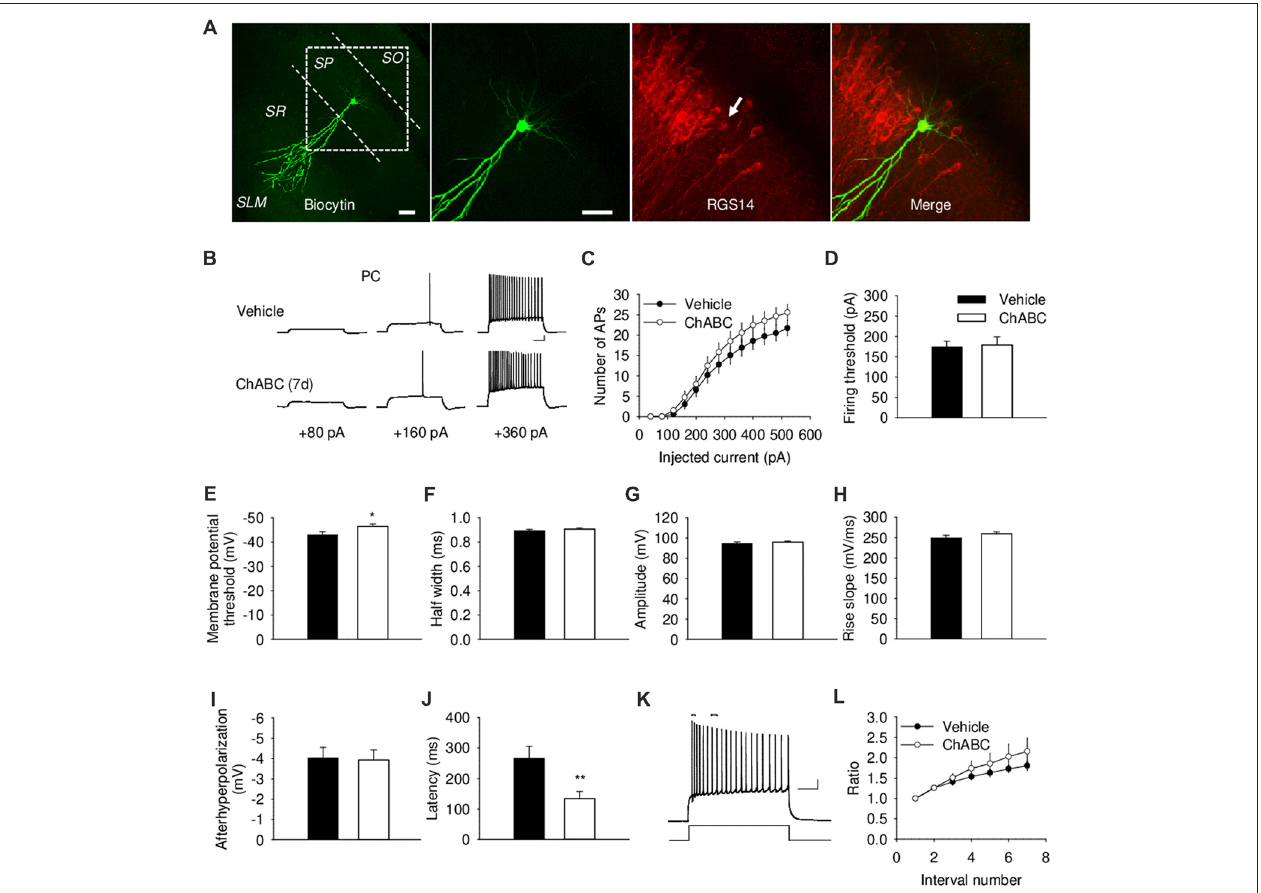
FIGURE 2 | Basic electrical properties of CA2 pyramidal cells (PCs) 7 days (7 d) after intrahippocampal injection of ChABC. (A) Intracellular labeling of the recorded CA2 PC. Scale bar, 50 µ m. (B) Sample traces of action potentials (APs) recorded in the CA2 PC in response to depolarizing current injections 7 d after vehicle/ChABC injection. Scale bar, 10 mV/100 ms. (C) Summary graph showing the number of action potentials (APs) elicited in CA2 PCs in response to step-wise depolarizing currents of increasing amplitude. Two-way RM ANOVA, ChABC effects: P > 0.05. Bar graphs comparing ChABC- ( n = 20) vs. vehicle-treated ( n = 18) CA2 PCs in terms of the firing threshold (D) , the threshold depolarization necessary for action potential generation (E) , the half-width of action potentials (F) , the amplitude of action potentials (G) , the rise slope of action potentials (H) , the after-hyperpolarization of action potentials (I) , the action potential latency of PCs (J) . (K) An example of action potential adaptation. Scale bars, 10 mV/100 ms. Upper bars indicating the first and last intervals used to calculate action potential adaptation. (L) Action potential adaptation, measured as a ratio of the interval between the first two and following pairs of action potentials generated at 520 pA current step. Bars represent mean ± SEM values. ∗ P < 0.05, ∗∗ P < 0.01, t -test, compared with